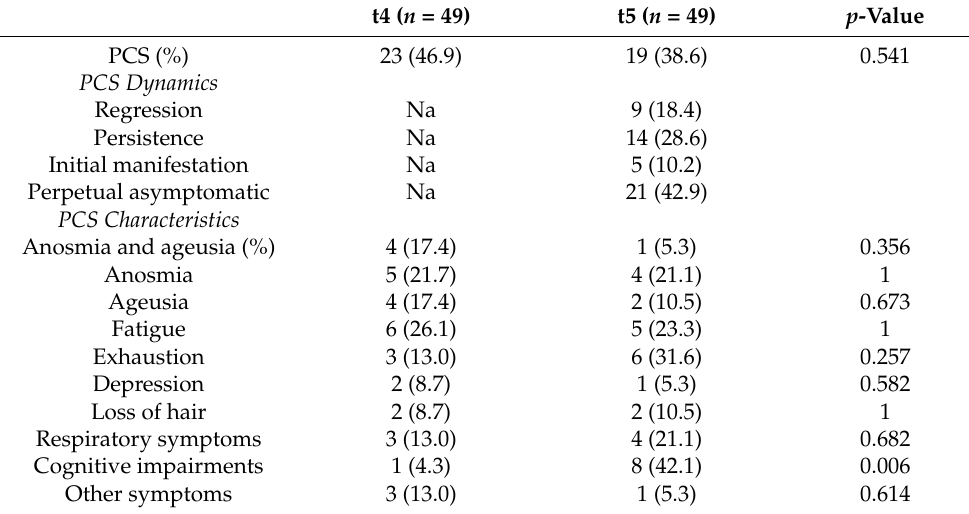
Figure 6. Post-COVID Syndrome dynamics. The existence of PCS at the 6-month and the 12-month appointments is compared. In addition, the distribution of the individual symptoms, and especially the increase in cognitive symptoms, is shown in the pie chart. Table 5. Comparison of PCS prevalence and symptoms of recovered subjects 6 and 12 months after study inclusion (all subjects, V1).